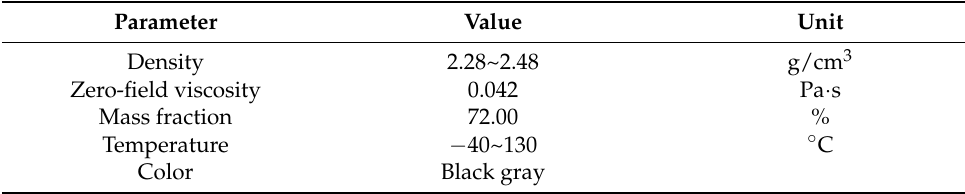
Table 1. MRF-122EG performance parameters. Parameter Value Unit Density 2.28~2.48 g/cm 3 Zero-field viscosity 0.042 Pa · s Mass fraction 72.00 % Temperature − 40~130 ◦ C Color Black